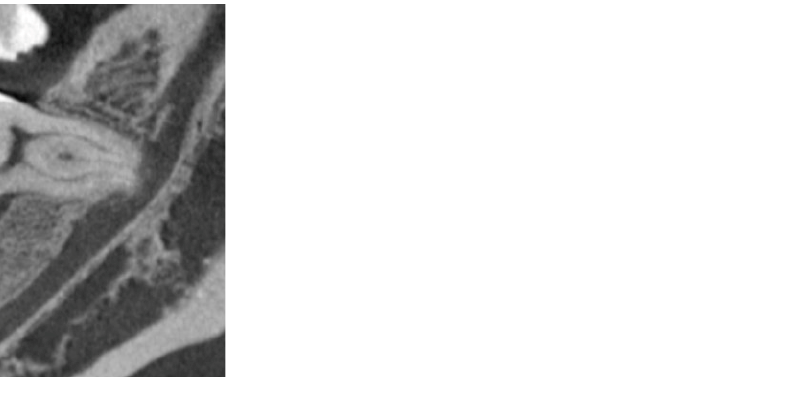
Figure 3. Representative CBCT image showing bone loss at the distal of a left lower second molar with root resorption (white arrow) caused by a mesioangular impacted third molar.